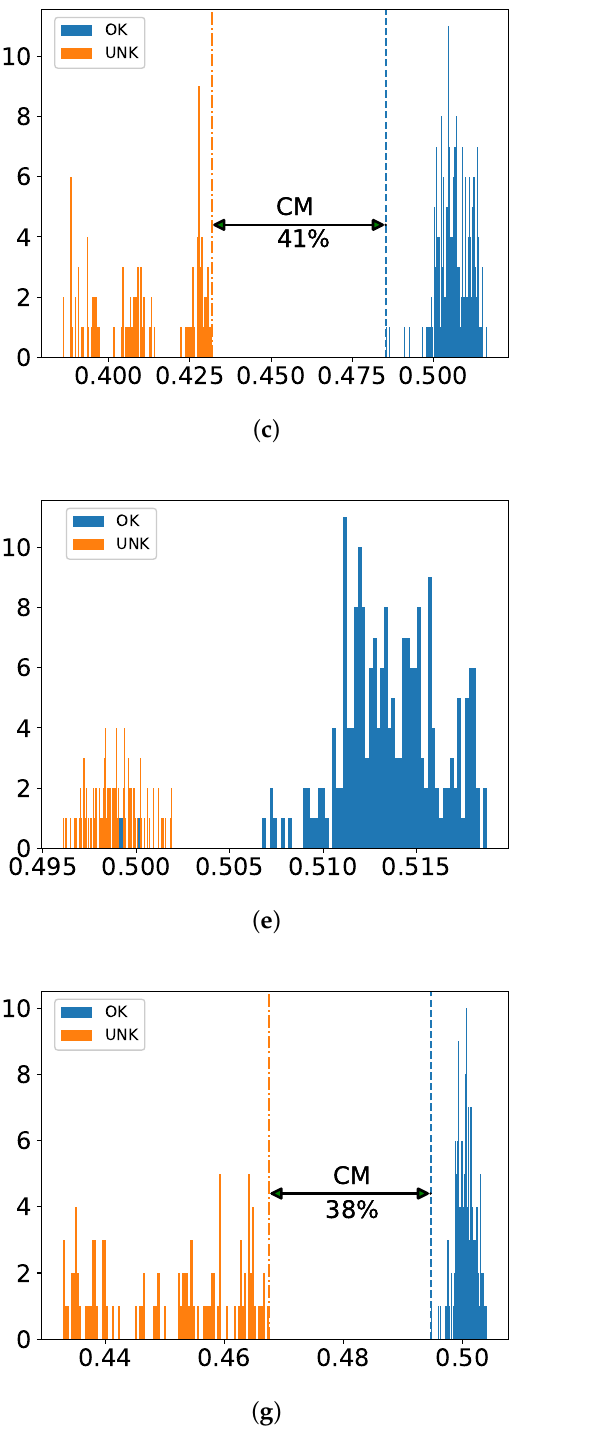
Figure 9. Histogram of one-class classifiers with the dataset Sinc-150k. CM in Equation (1) is reported if available. Values on the x -axis are normalized classifier scores according to Equations (2)–(5). ( a ) HMM with PFA; ( b ) HMM with SFA; ( c ) SVM with PFA; ( d ) SVM with SFA; ( e ) IF with PFA; ( f ) IF with SFA; ( g ) AE-BN with PFA; ( h ) AE-BN with